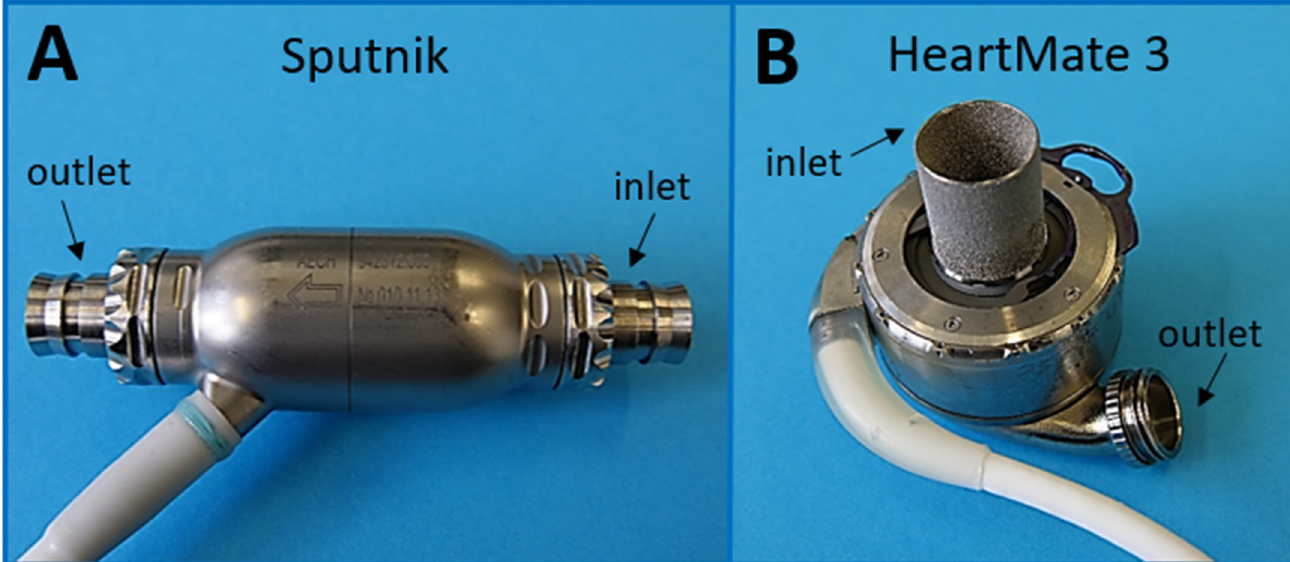
Figure 1. ( A ) Picture of Sputnik LVAD; ( B ) Picture of HeartMate 3 LVAD. For further details on the internal design of both pumps, refer to Mehra et al. [32].